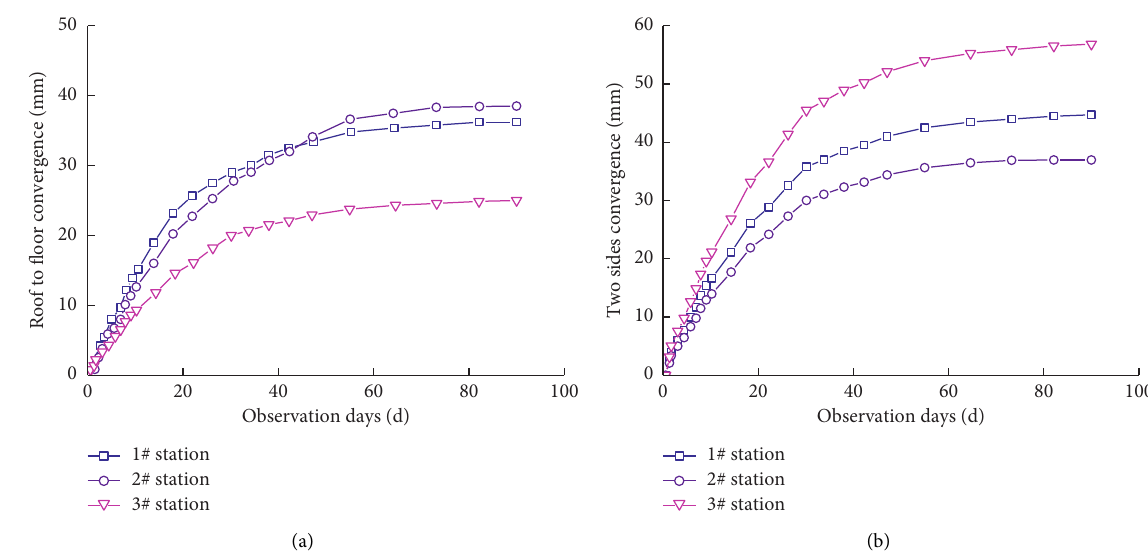
Figure15 : Relationship curve of roadway deformation with time. (a) Roof-to-floor convergence. (b) Two sides’ convergence.